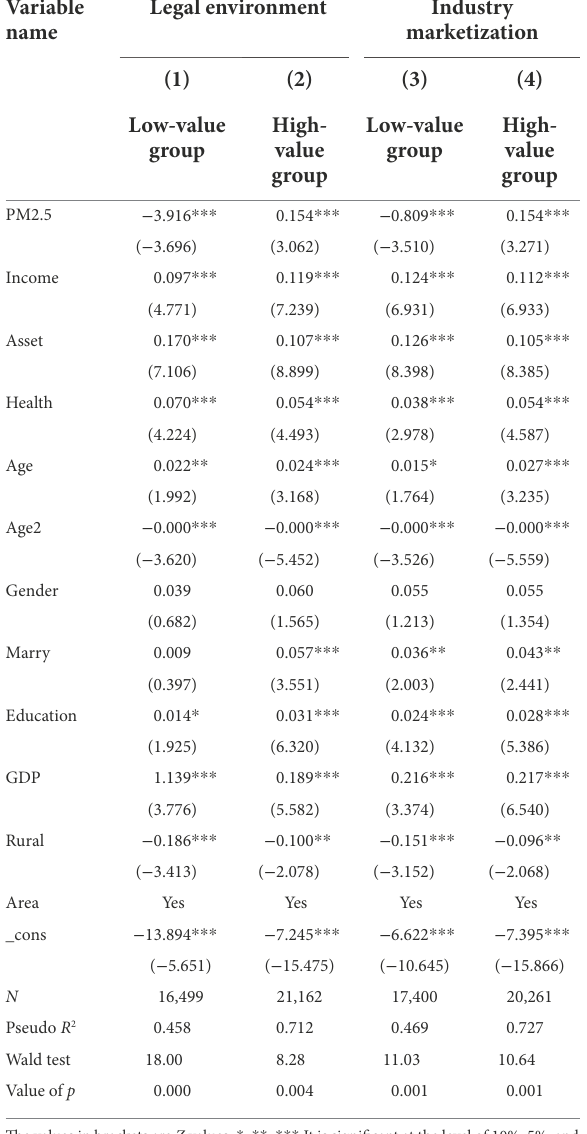
TABLE 3 The impact of haze pollution on demand for commercial health insurance: an analysis based on the formal system. Variable name